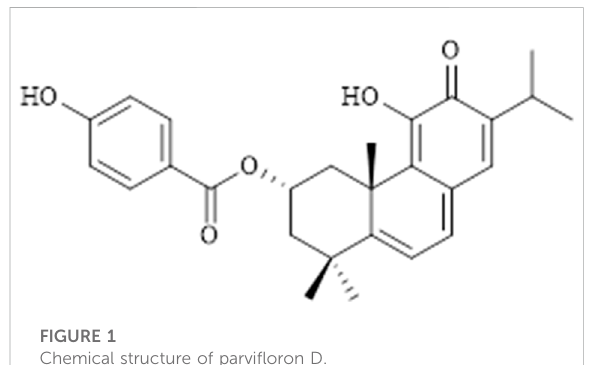
FIGURE 1 Chemical structure of parvi fl oron